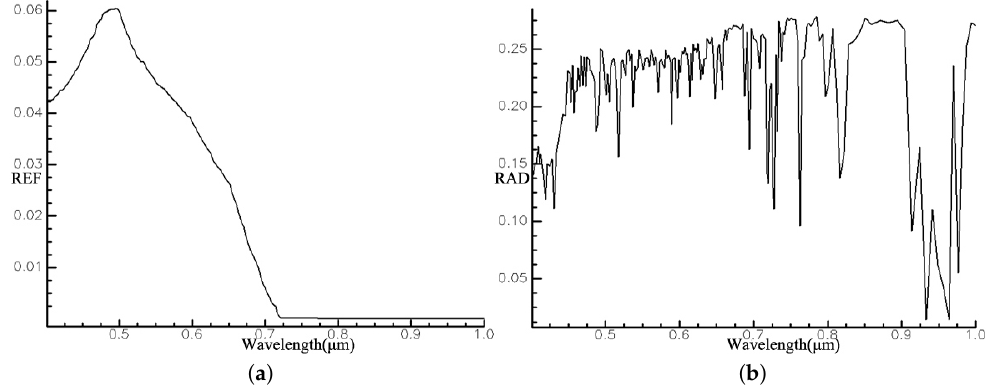
Figure 8. The spectral reflectance and simulated radiance of clear lake water. ( a ) Reflectance; ( b )